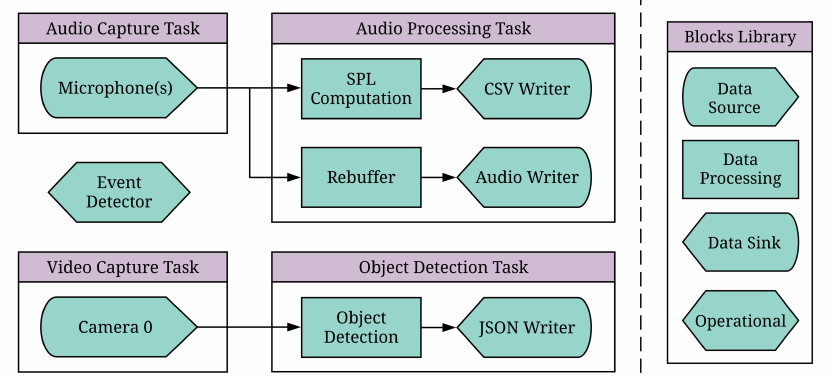
Figure 5. Multimodal smart traffic event detection pipeline. This pipeline handles both audio and video. It captures video, passes it to an object detection Block, and then writes the detection outputs to JSON files. It also captures audio at short intervals (1 s) and computes SPL at the 1 s resolution, as well as accumulates the audio into longer clips and writes them to disk as audio files. Finally, the salient event detection block is monitoring these files, preserving only those that had an event of interest detected in